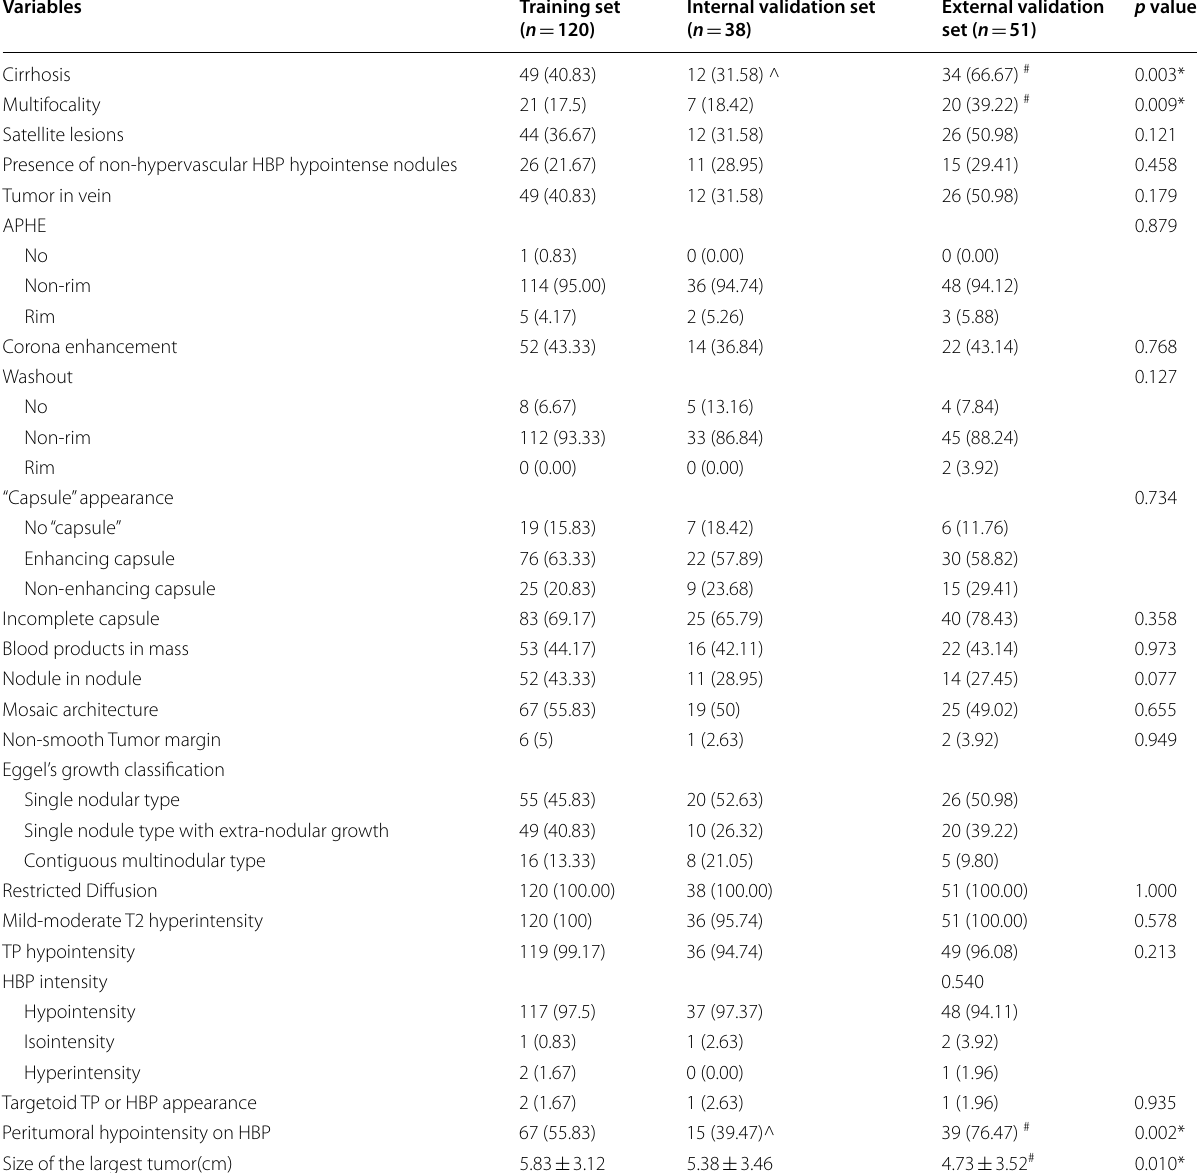
Table 2 Imaging findings of the training, internal validation and external validation